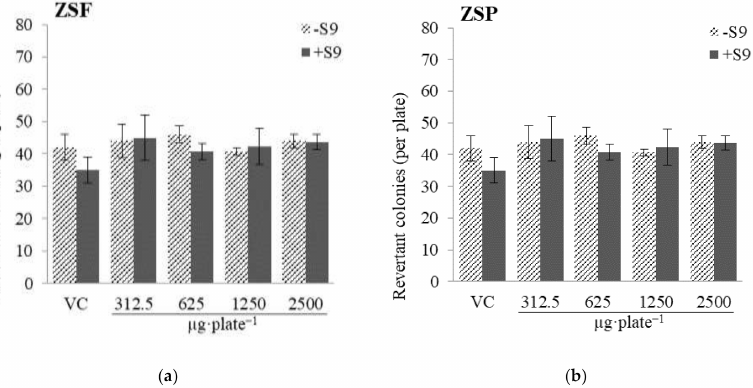
Figure 1. Results of mutagenicity test of Zanthoxylum schinifolium extracts (( a ) ZSF: Z. schinifolium fruit extract, ( b ) ZSP: Z. schinifolium pericarp extract) in Salmonella typhimurium TA98, with or without the S9 mix. In the positive control, the number of revertant colonies are 267 ± 12 and 785 ± 33, with or without the S9 mix. The S9 mix consists of the rat liver S9 fraction and other co-factors. Data are expressed as the mean ± SD of triplicate experiments. VC, vehicle control (DMSO).